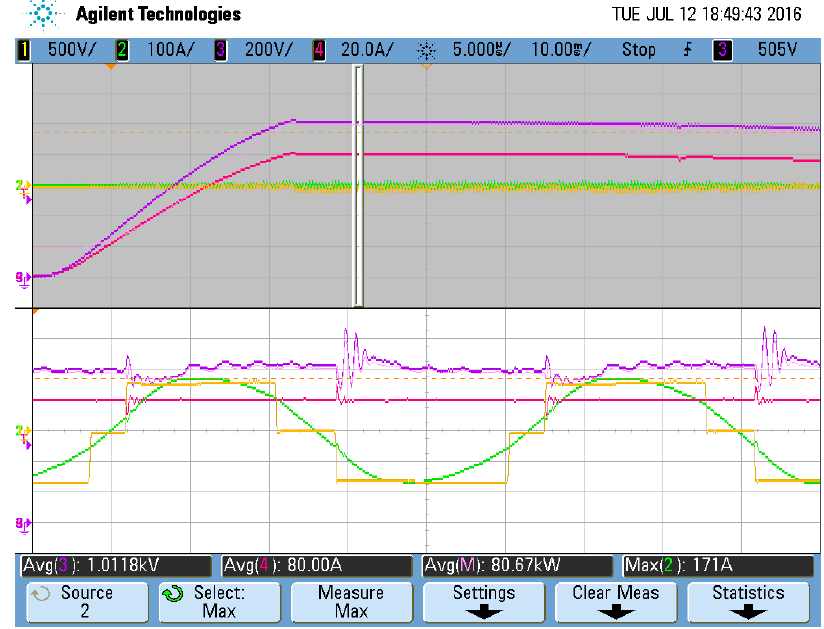
Figure 12. Experimental waveforms. V AB (yellow), i PL (green), V O (magenta). Bottom: Zoom of the top waveform.